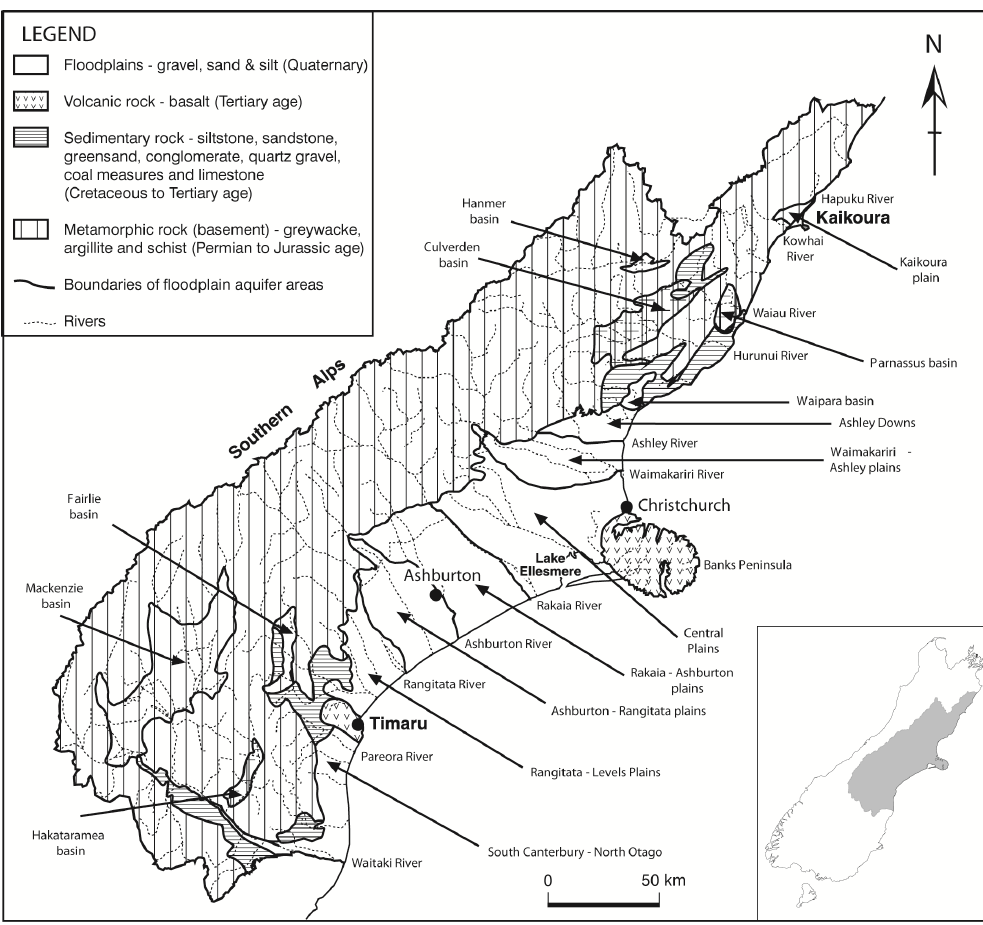
Figure 7. Hydrogeological setting of the Canterbury region (adapted from Brown, 2001).